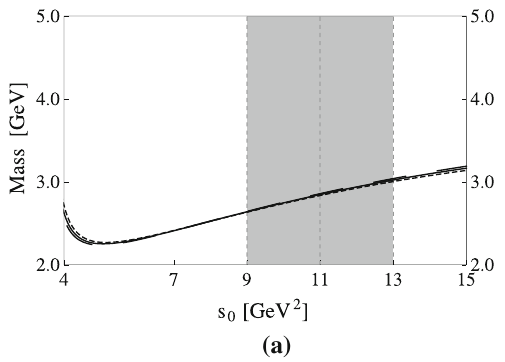
, with 1 . 78 / 1 . 85 / 1 . 92 GeV 2 , respectively; b the short-dashed/solid/long- 1 α 2 α 3 α 4 dashed curves are obtained by setting s 0 = 10 . 0 / 11 . 0 / 12 . 0 GeV 2 , = B